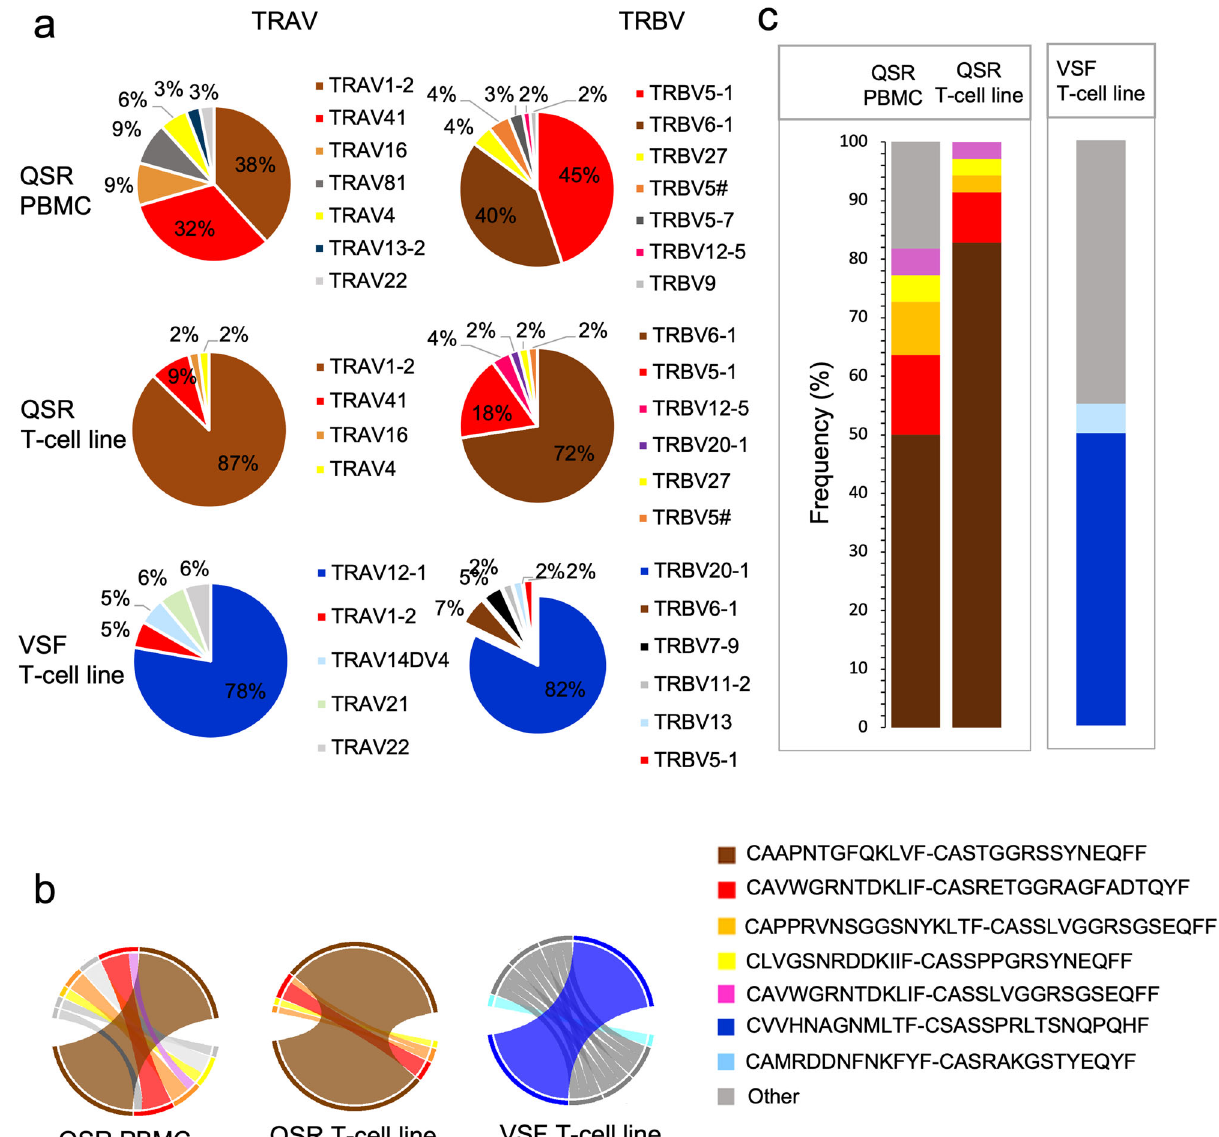
Fig. 8 Single-cell TCR repertoire speci fi c to QSR and VSF epitopes from an HLA-B*57:01 donor display dominant TCR clonotypes. QSR PBMC represent single cells speci fi c to QSR isolated from PBMC; QSR T-cell line represent single cells speci fi c to QSR isolated from EBV-speci fi c T cell line; VSF T-cell line represent single cells speci fi c to VSF isolated from EBV-speci fi c T cell line. a Each pie chart illustrates the frequency of TCR α and TCR β sequences of sorted CD8 + tetramer speci fi c cells from a single donor (Donor 1). Pie chart colors match clonotypes. b Circos plots displaying paired TCR α / β CDR3 combinations in the PBMCs and T cell lines, colors are coded to match that shown in ( c ). The thickness of each segment is proportional to the frequency of the TCR α / β pair. c Data from circos plots represented as percentages. Data are color matched to ( b ) where possible, whilst the remaining unique combinations are shown grouped (gray) and marked as